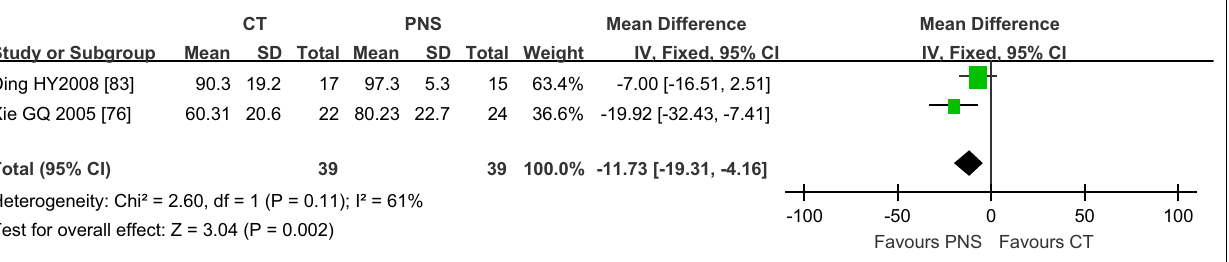
FIGURE 6 | Results of meta-analyses on Barthel index (BI) (2 trials) . PNS treatment significantly increased BI compared to RT (MD = -11.73; 95% CI = -19.31, -4.16; P = 0.002). PNS, Panax notoginseng saponin; CT, Current treatment.